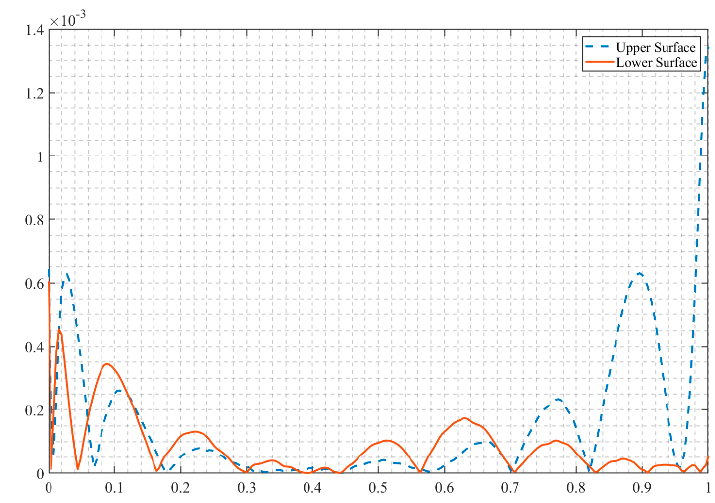
Figure 5. Fitting accuracy of the 8th-order CST parameterization method.